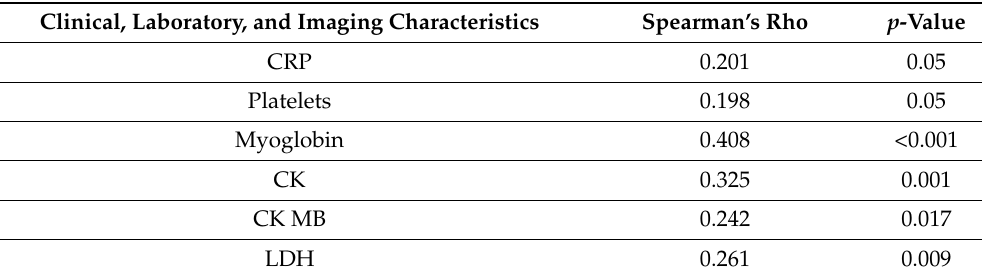
Table 3. Correlations of clinical and laboratory parameters with pericardial